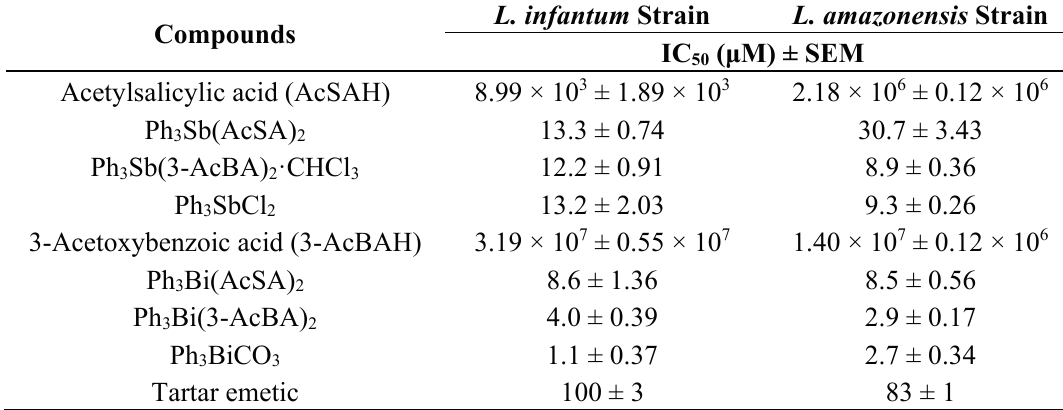
Table 1. Inhibitory concentrations of triphenyl Sb(V) and triphenyl Bi(V) complexes of acetylsalicylic acid and 3-acetoxybenzoic acid, acetylsalicylic acid, 3-acetoxybenzoic acid and metal salts against L. amazonensis and L. infantum species promastigotes at 48 h [114].